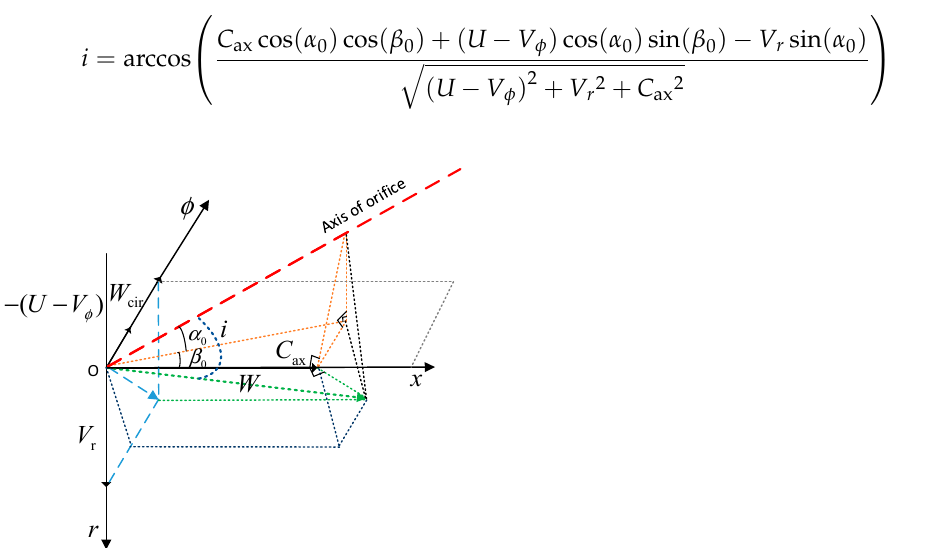
Figure 3. Definition of the comprehensive incidence angle.